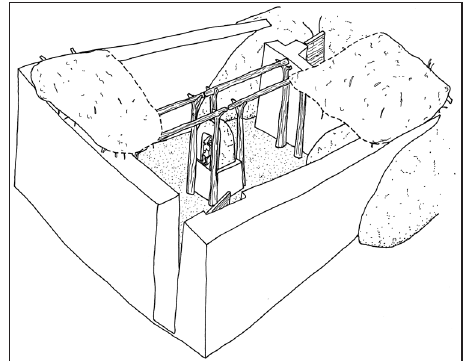
Fig. 7: Old Kingdom shrine of Satet on Ele- phantine island. (Reconstruction drawing by R. Bussmann).